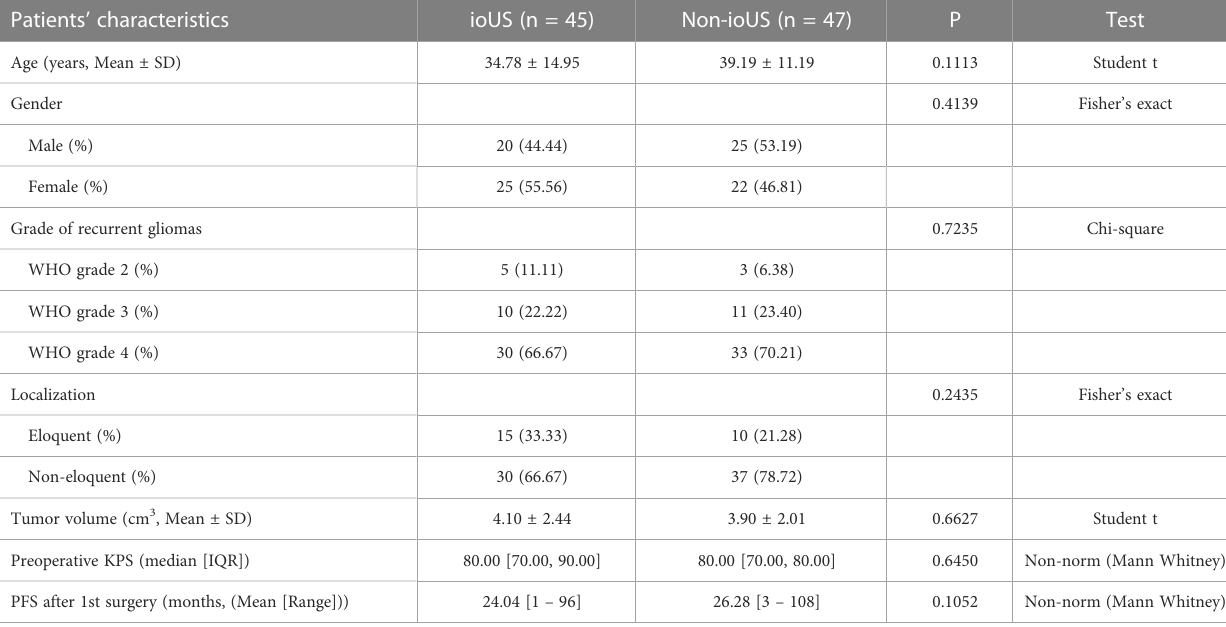
TABLE 2 Comparison between patients undergoing ioUS and patients not undergoing ioUS localization and guided surgical resection of recurrent gliomas. Patients ’